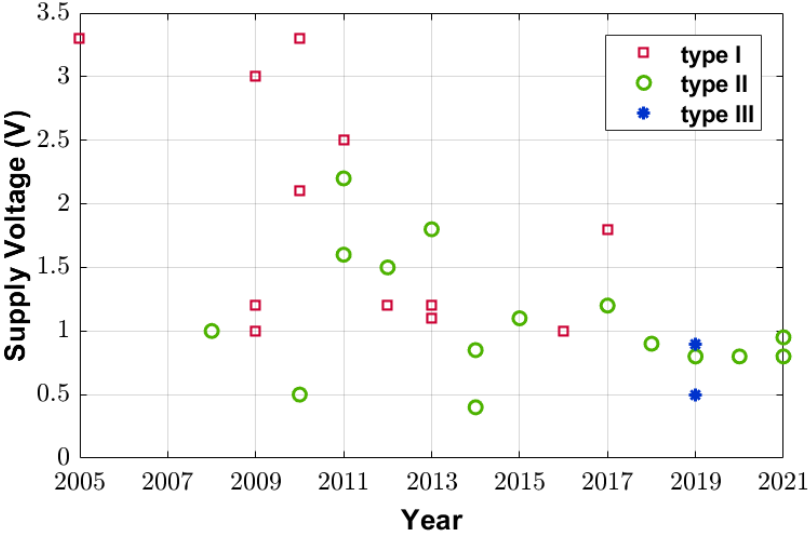
Figure 12. The supply voltage versus the year of publication for all three types of MOS-based temperature sensors.